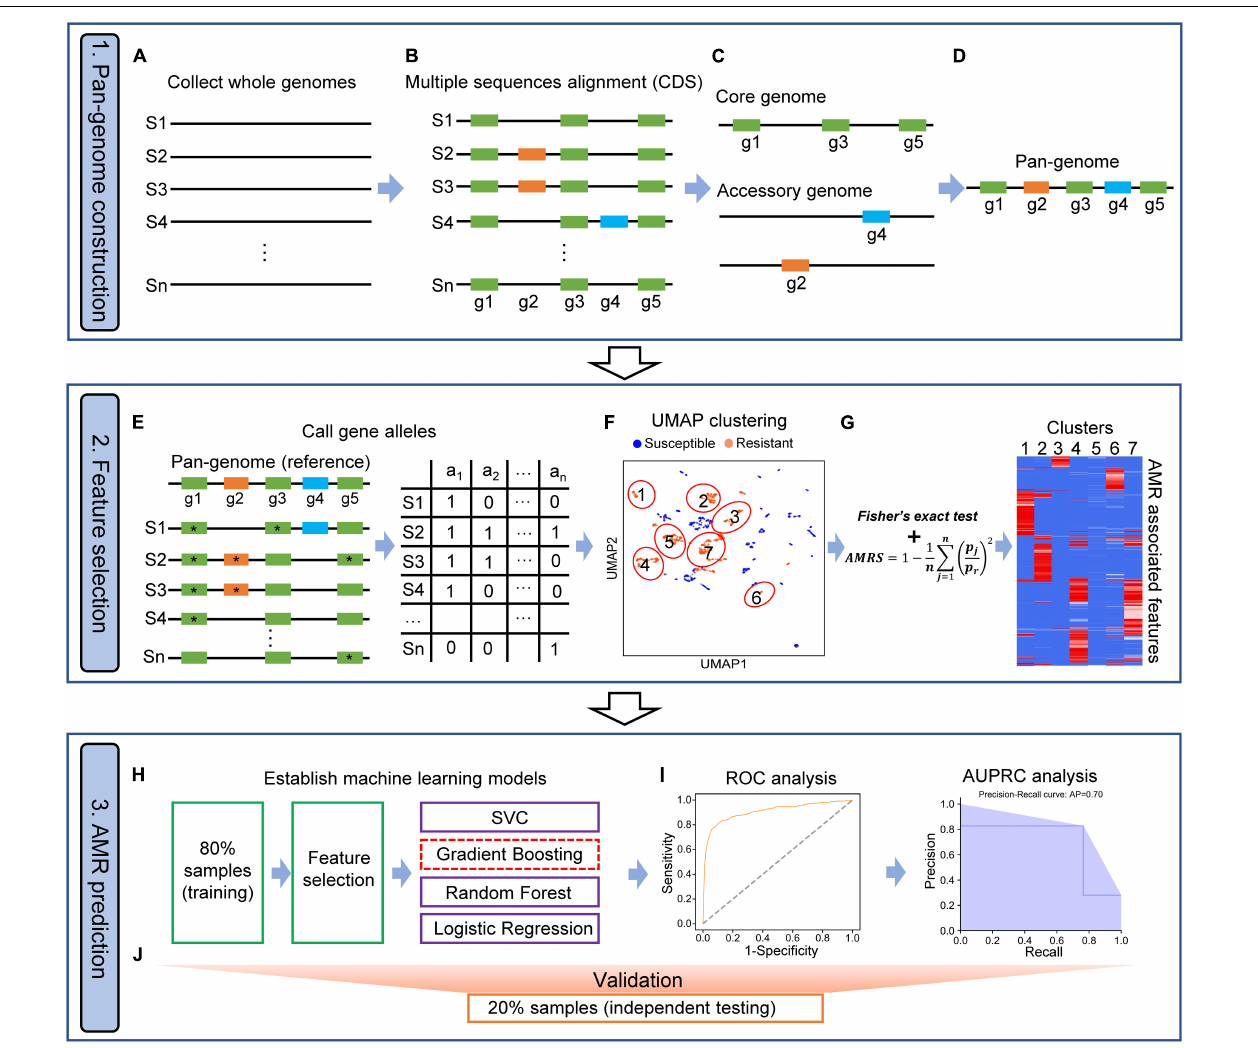
FIGURE 1 | Workflow of PARMAP (Prediction of Antimicrobial Resistance by MAPping genetic alterations in pan-genome) framework. (A) Collection of the genomic sequences of strains from public databases. (B) Multiple sequence alignment of protein sequences of all strains. (C) Identification of the core and accessory genome of a given species. (D) Construction of the pan-genome of a species by merging the core and accessory genomes. (E) Construction of the pan-genome gene allele matrix. (F) Classification of all strains using the uniform manifold approximation and projection (UMAP) algorithm. (G) Antimicrobial resistance (AMR)-associated features filtered by AMR score (AMRS). (H) Eighty percent of all strains were selected as the training dataset for feature selection and the development of four machine learning models, comprising support vector classification (SVC), gradient boosting (GDBT), random forest (RF), and logistic regression (LR), algorithms. (I) Machine learning models were optimized when they obtained the best area under the curve (AUC) and precision-recall (PR), curve values. (J) The remaining 20% of samples (the independent testing dataset) were used for evaluating the prediction